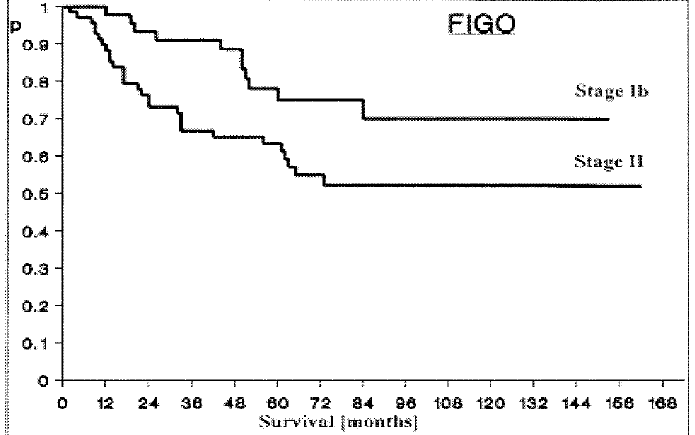
Fig. 1. Time of survival (months) correlated with clinical stage according to FIGO. The two groups constitute 46 (stage IB) and 70 (stage II) patients, respectively. P = 0 . 01.